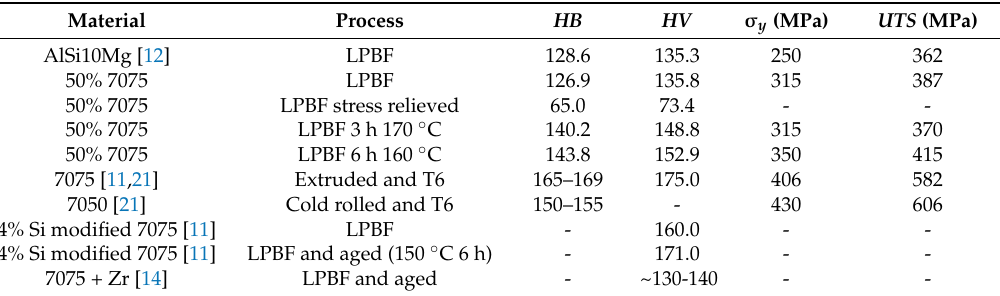
Table 5. Hardness values of 50% 7075 samples built with the optimized parameters compared with literature data related to other Al